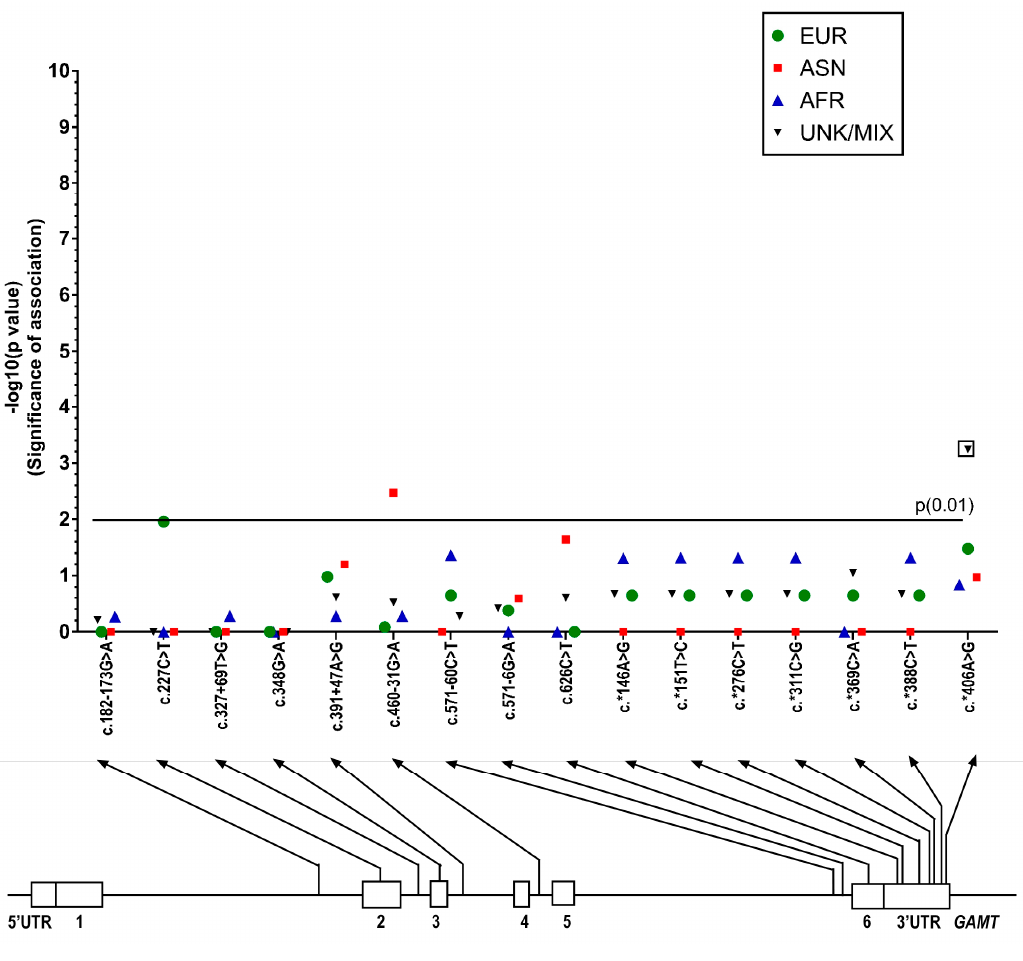
Figure 5. Manhattan plot showing the p -values from Fisher’s exact test (significance of association, plotted as -log ( p )) for each SNP sequenced on the guanidinoacetate methyltransferase ( GAMT ) gene. p -values are shown for European, East Asian, African, and Unknown/Admixed populations. The nominal statistical threshold for p = 0.01 is shown, and p -values that are still significant after running the Benjamin–Hochburg procedure are indicated with boxes. The location of each SNP is shown on the GAMT gene below the x-axis. EUR: European; ASN: East Asian; AFR: African; UNK/MIX: Unknown/Admixed populations.